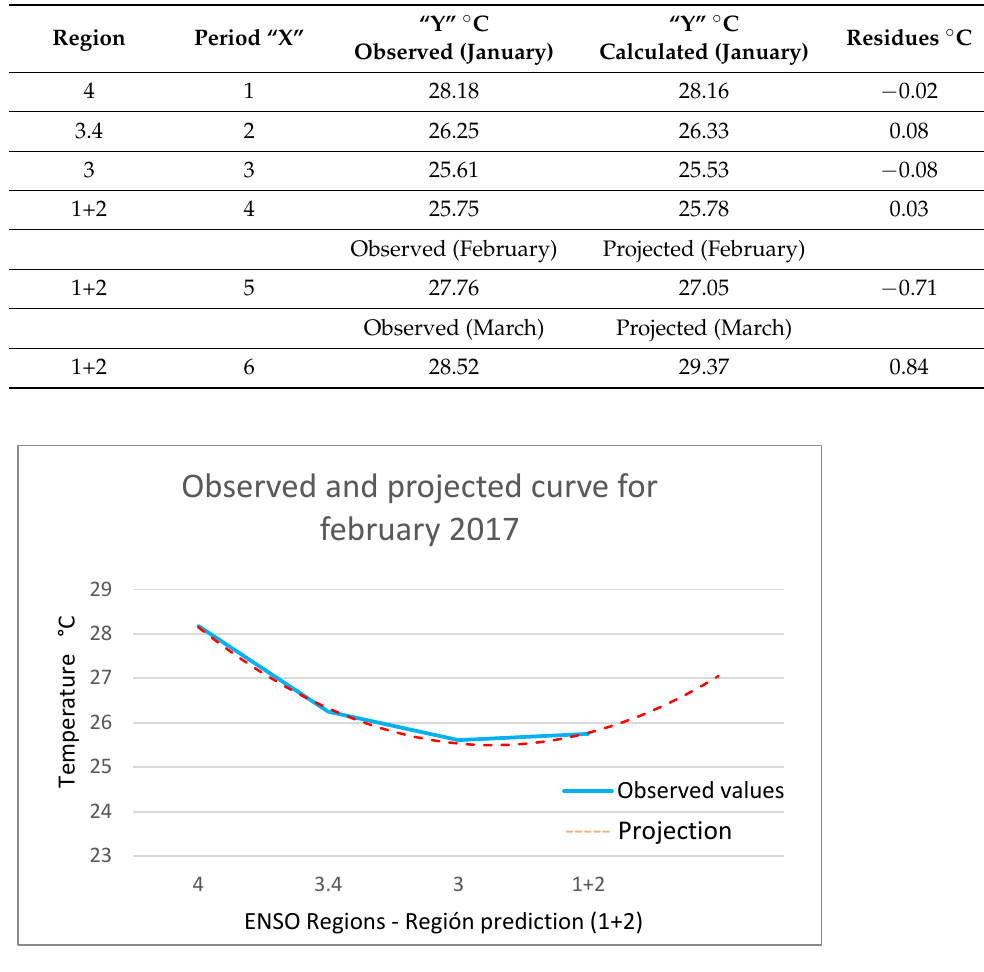
Figure 12. Example of the SST projection for zone 1 + 2 (Niño Costero) for the month of March.